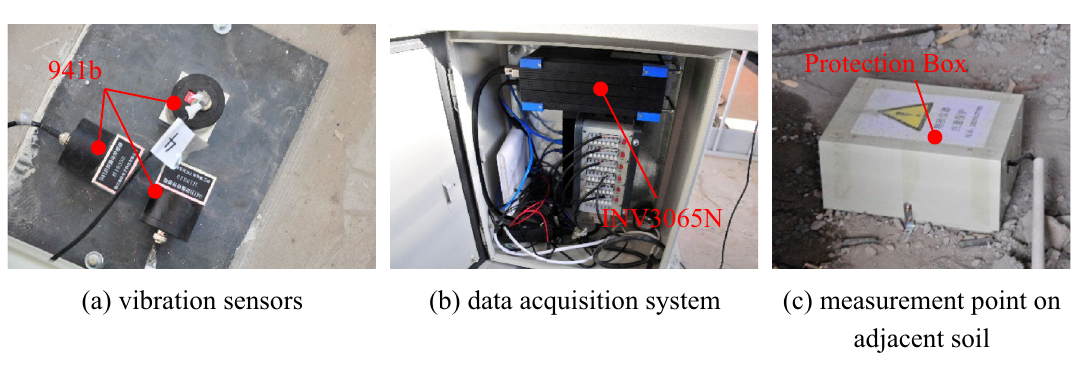
Figure 7. Long-term monitoring point arrangement at point